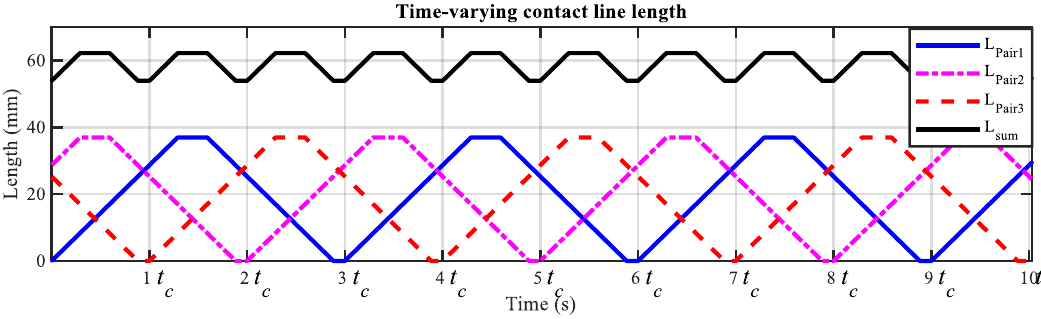
Figure 2. Contact line length of a helical gear pair.